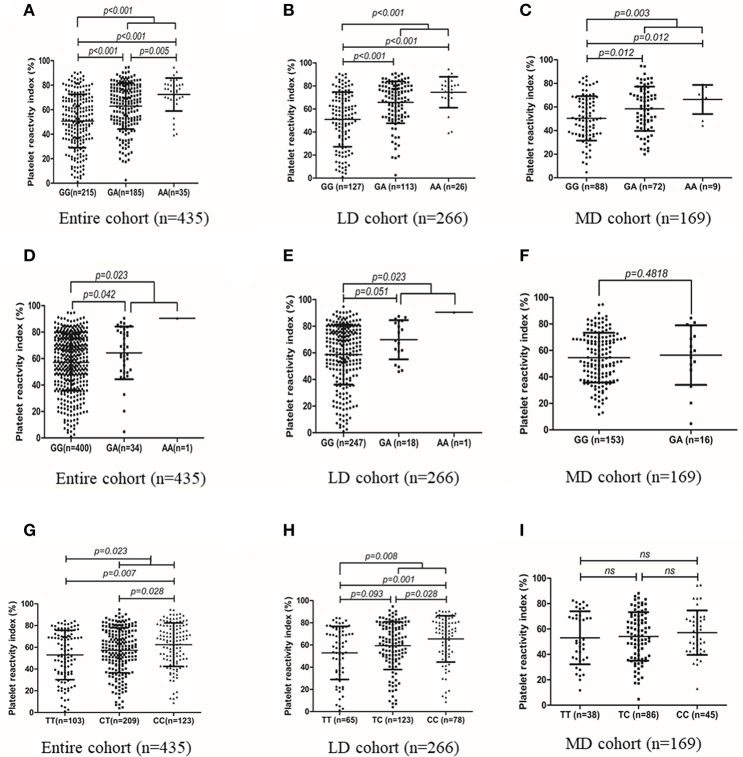
Association of CYP2C19*2 with PRI value in entire cohort (A), LD cohort (B) and MD cohort (C). Association of CYP2C19*3, with PRI value in entire cohort (D), LD cohort (E) and MD cohort (F). Association of N6AMT1 rs2254638 with PRI value in entire cohort (G), LD cohort (H) and MD cohort (I).